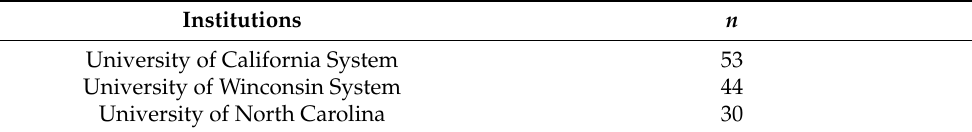
Table 5. Institutions.